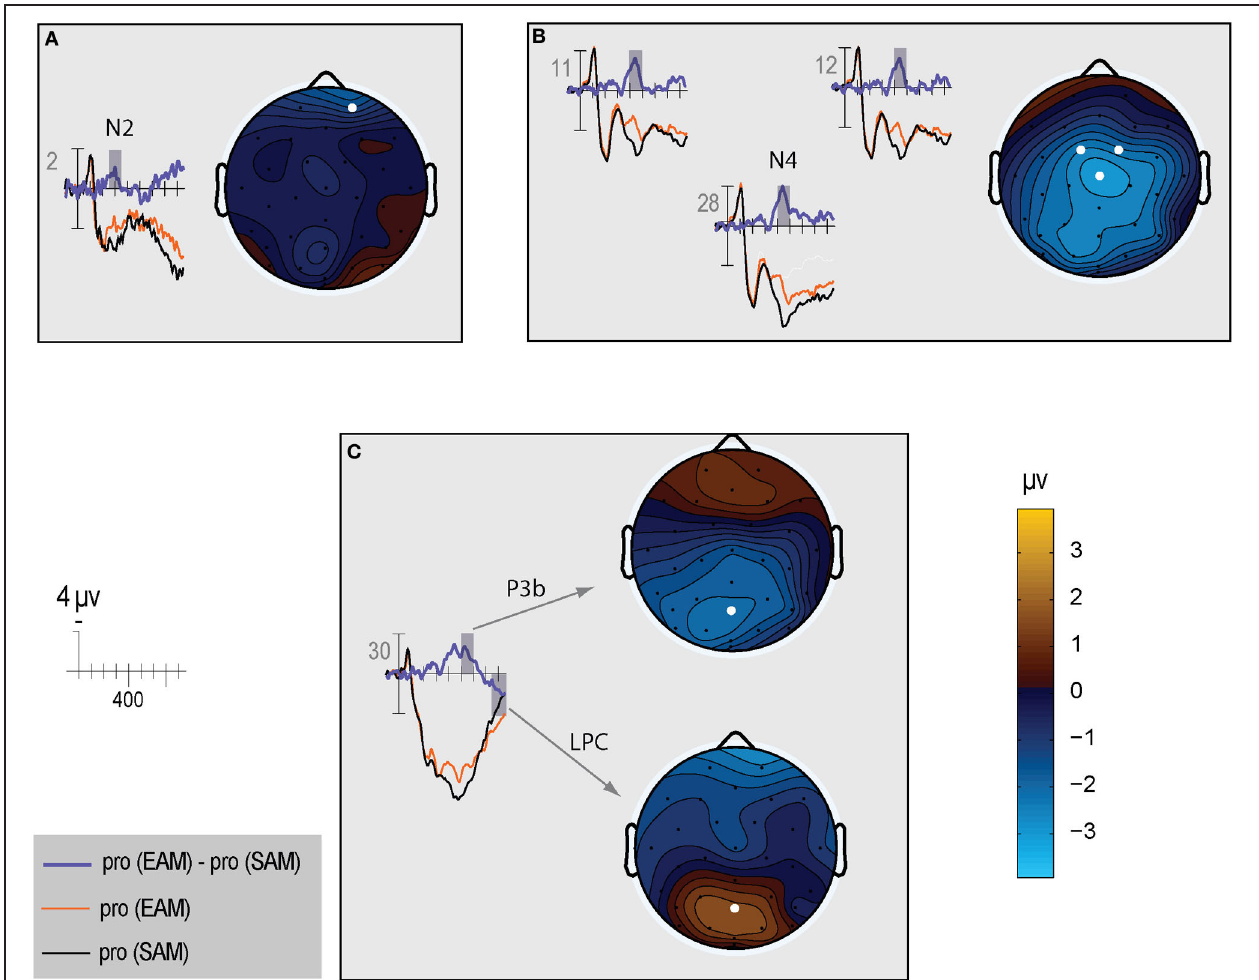
FIGURE 5 | The left side of each panel shows the ERP time course for episodic probes (thin orange line), semantic probes (thin black line), and difference between episodic and semantic probes (thick